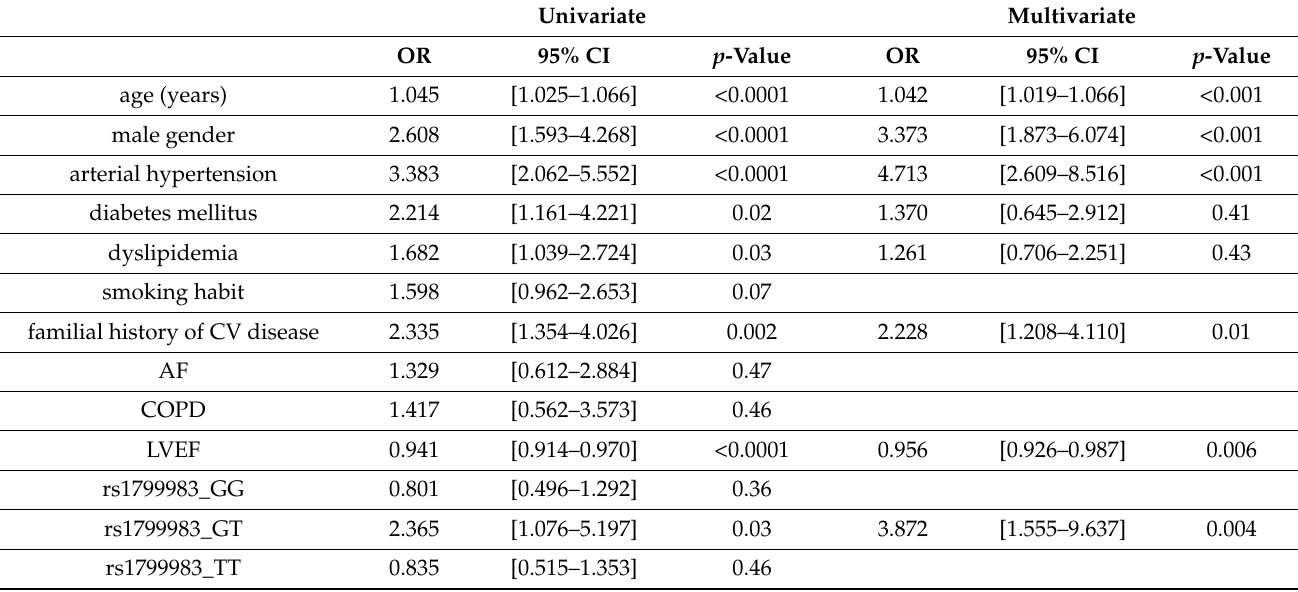
Table 3. Predictors of ischemic heart disease in univariate and multivariate analyses. Beyond the role of traditional cardiovascular risk factors, the allelic variant GT of the nitric oxide synthase 3 gene single-nucleotide polymorphism (SNP) rs1799983 is an independent predictor of ischemic heart disease.